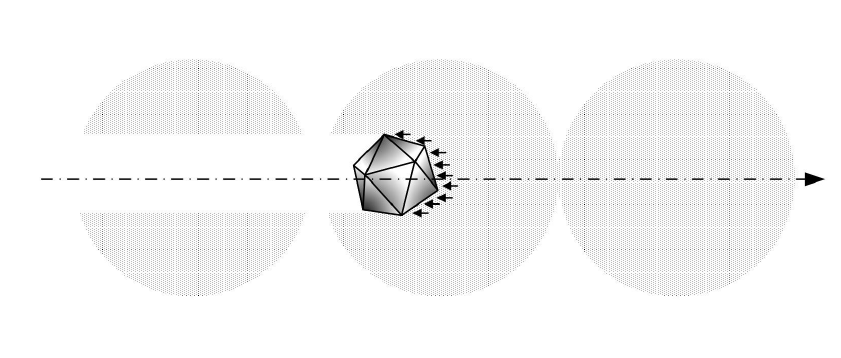
Figure 5. Soft deceleration of debris (safely) by a dust